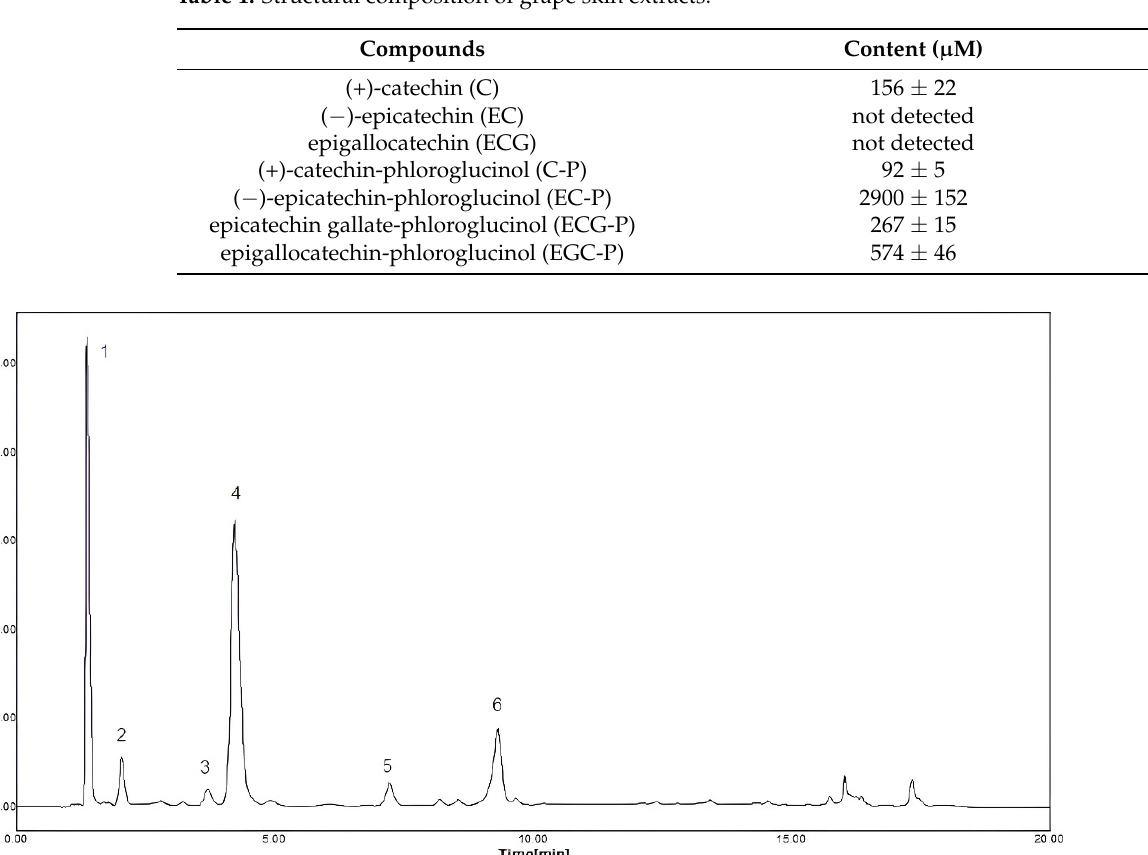
Table 1. Structural composition of grape skin extracts.